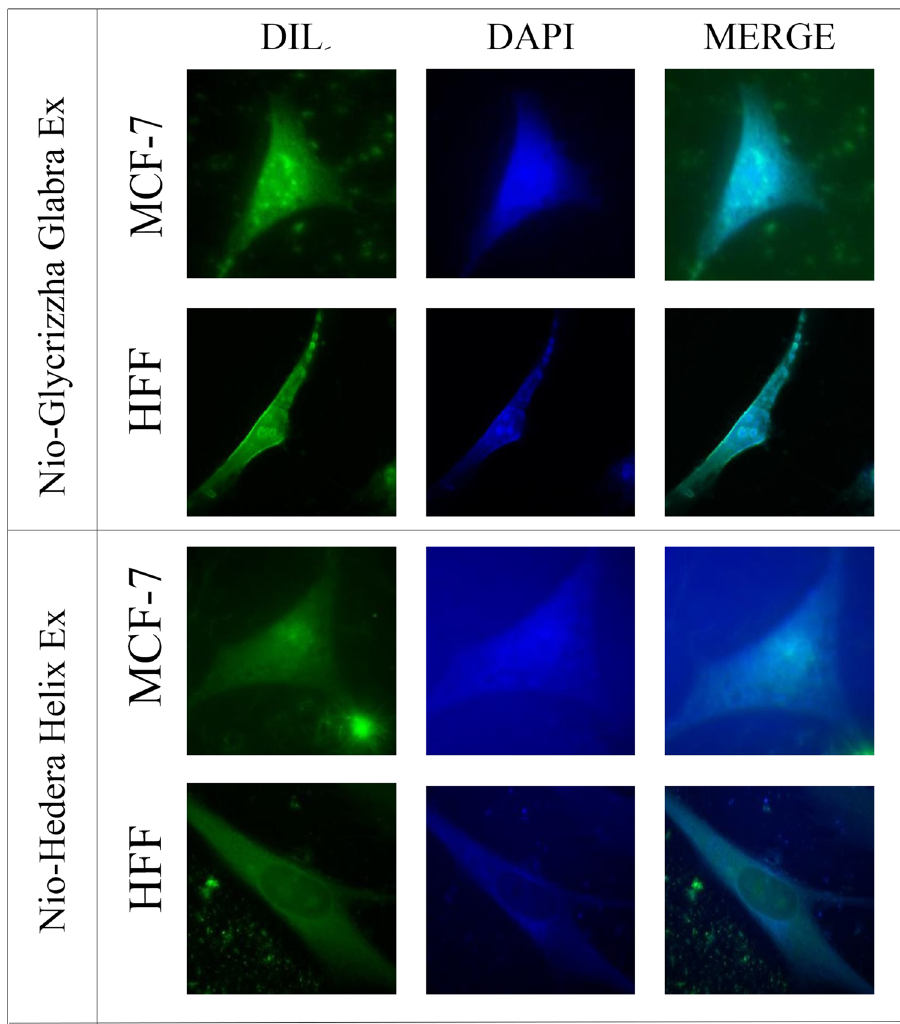
Figure 8: Intracellular delivery of niosomes containing extracts to MCF - 7 cancerous cells and HFF normal cells. The nuclei is counterstained with DAPI ( blue fl uorescence ) . Dil dye is used in order to stain the phospholipid ( green ) . Merge is the result of the integration of DAPI and Dil images which indicates the successful entry of nanoparticles into the